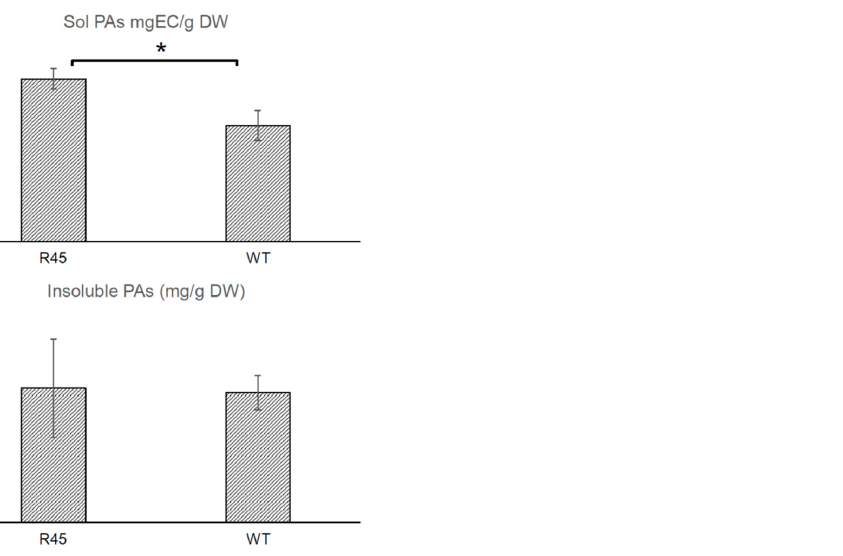
terised in other species (Figure 5).